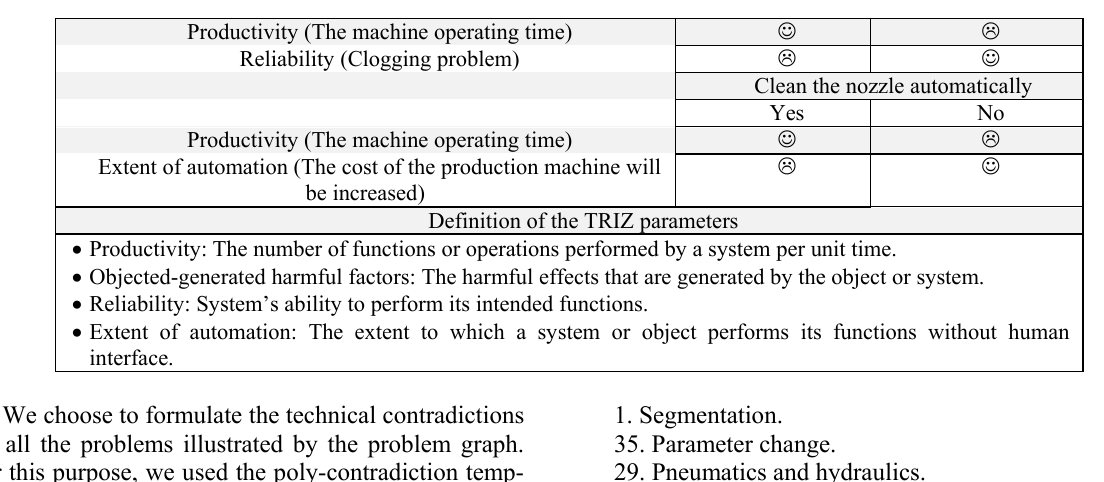
Table 3. The proposed principles in contradiction matrix Worsening Weight of feature Improving feature